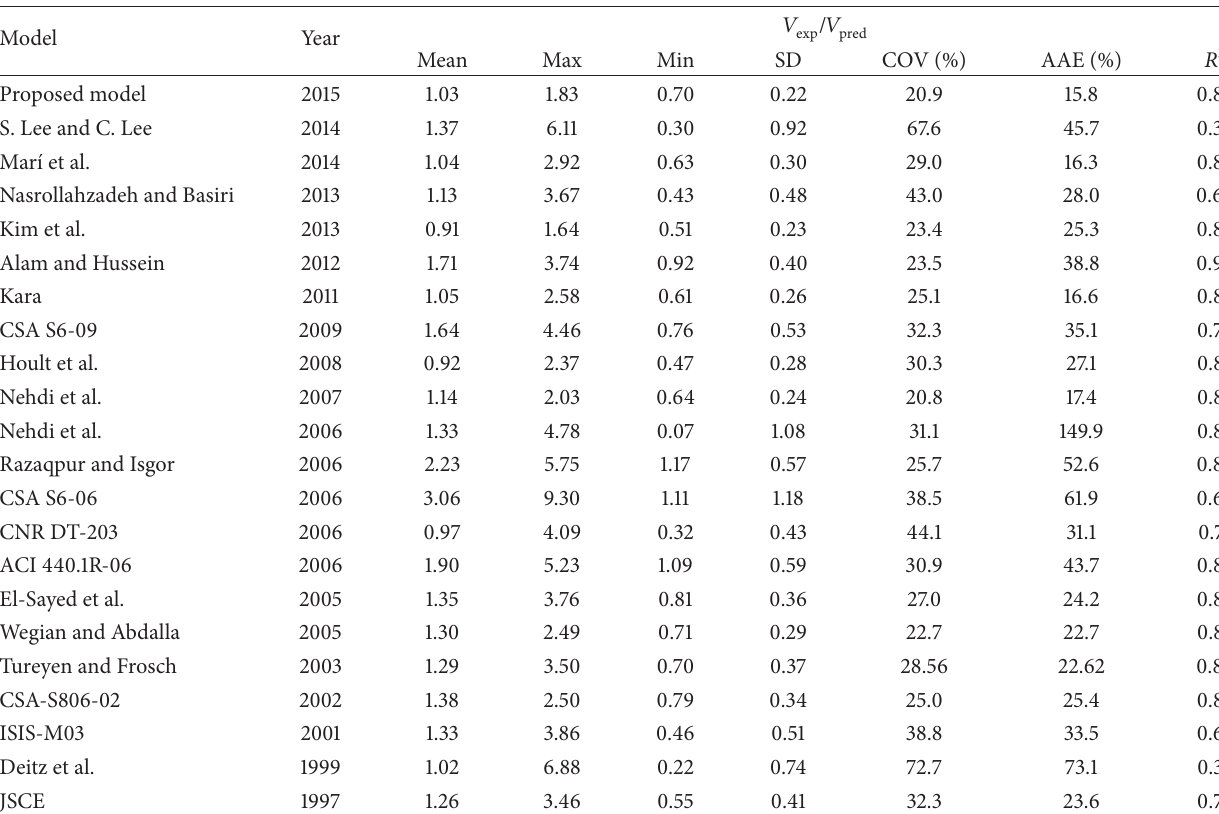
Table 2: Analysis of statistical parameter of all available